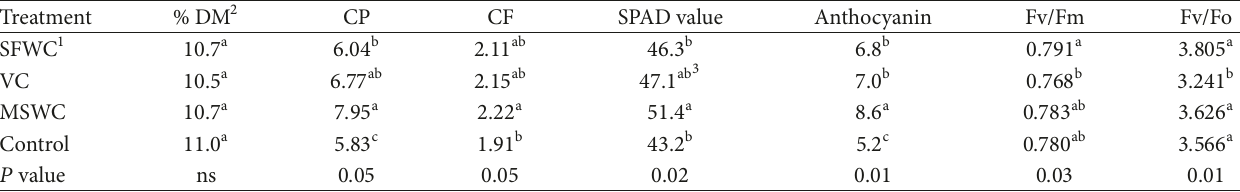
Table 1: Onion “Sweet Utah” plant growth and development parameters as affected by different growing medium organic amendments. Treatment